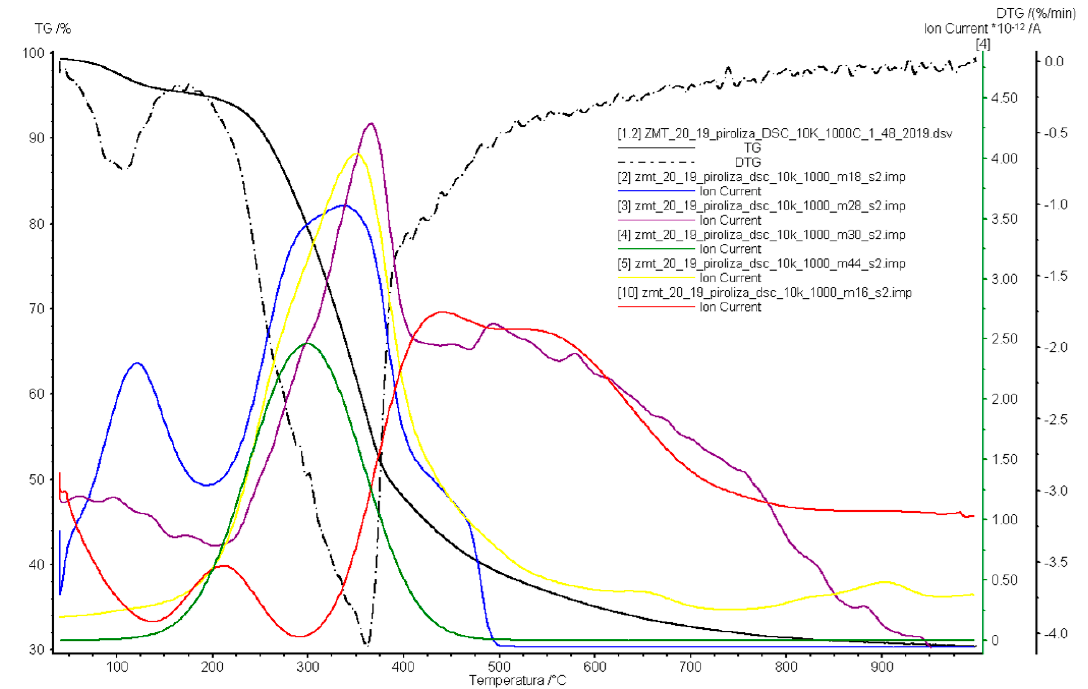
Figure 4. TG and DTG, curves and ion current intensity for the sample ZMT/20/2019 (own research).